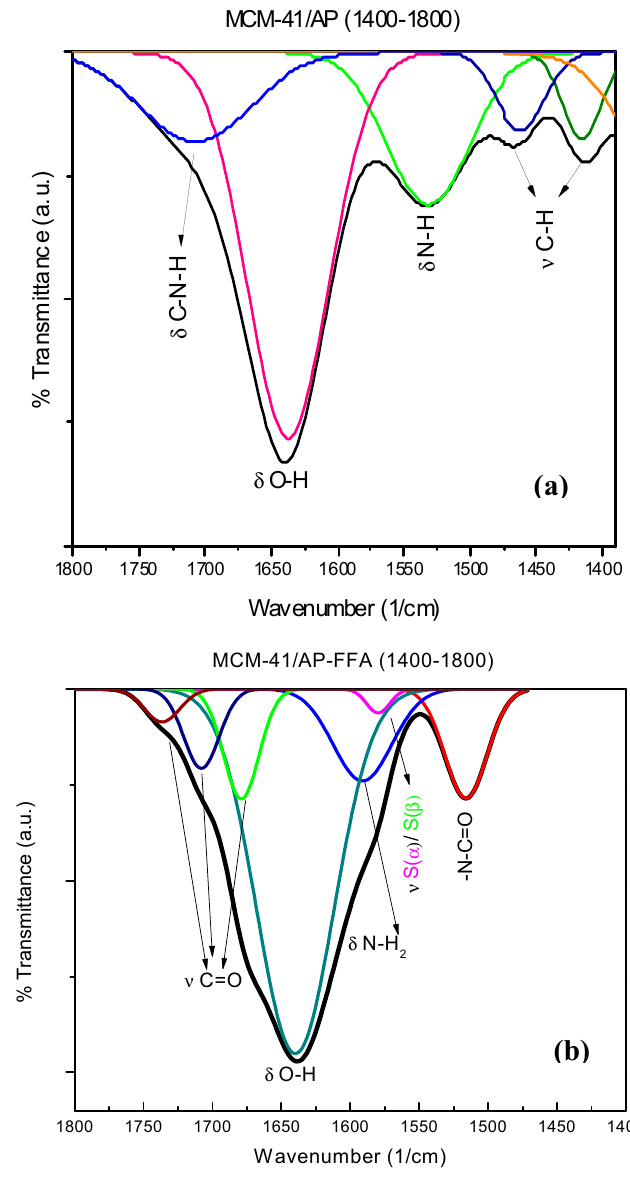
Figure 5. Refined FTIR spectra of the 1400–1800 cm − 1 bracket. ( a ) MCM-41/AP; ( b ) MCM-41/AP-FFA.